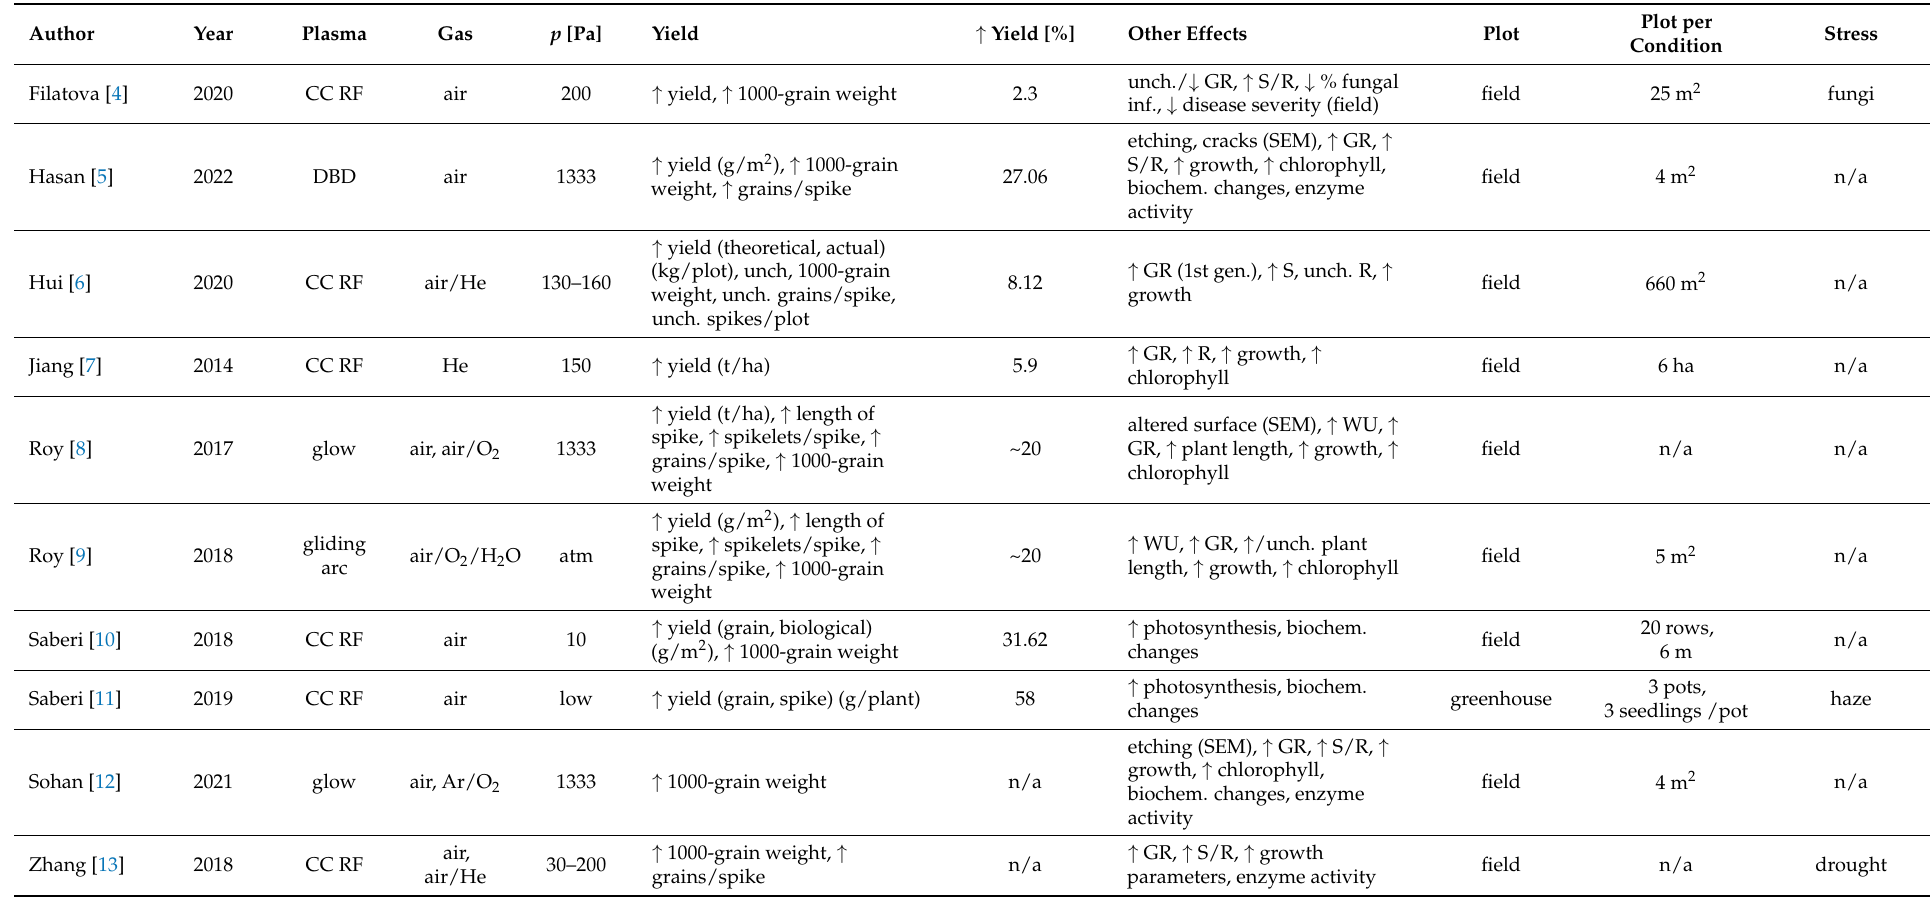
Table 1. An overview of publications regarding the effects of plasma treatment on wheat yield. CC: capacitively coupled, RF: radio frequency, DBD: dielectric barrier discharge, GR: germination rate, WU: water uptake, S: sprout, R: root, SEM: scanning electron microscopy, ↑ : increase, ↓ : decrease, unch.: unchanged, n/a: not